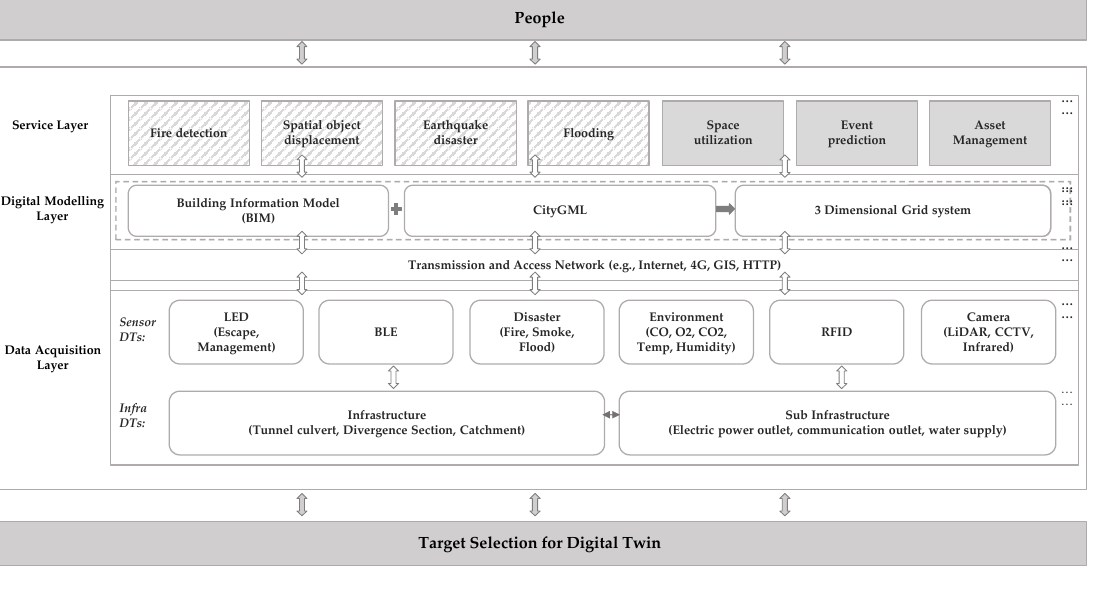
Figure 1. Methodology for constructing a digital twin in an underground utility tunnel.